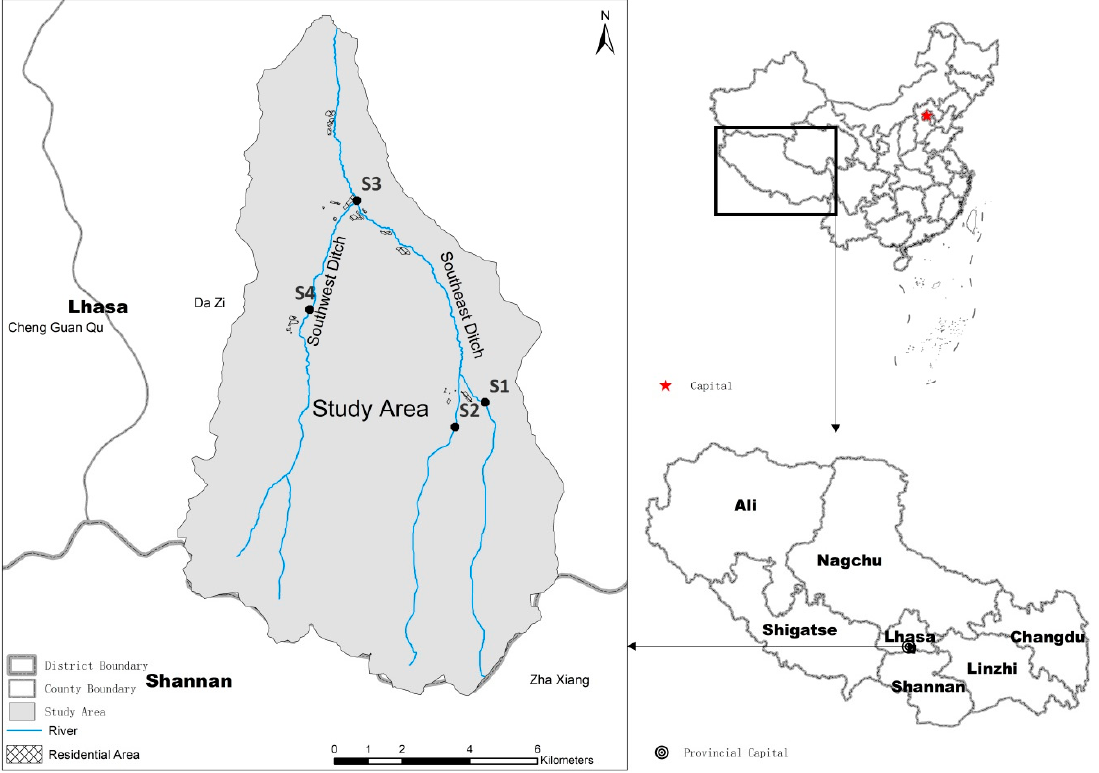
Figure 1. Map to show the location of our study area and sampling sites (S).